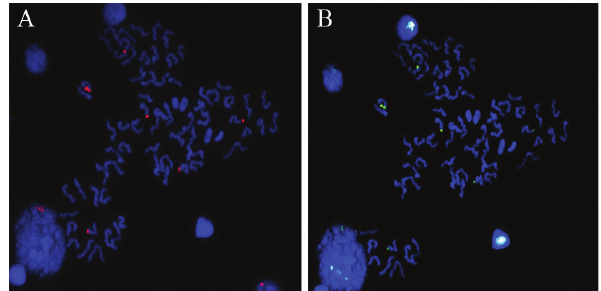
Figure 4. Chromosomes of Ctenus ornatus , Ubatuba/São Paulo state. A Metaphase II, FISH with rDNA 18S probe B sequential staining with DAPI/CMA in the same metaphase II, showing association be- 3 tween sites of GC-rich heterochromatin and rDNA 18S regions. Note the presence of more than one metaphase II. Bar = 10